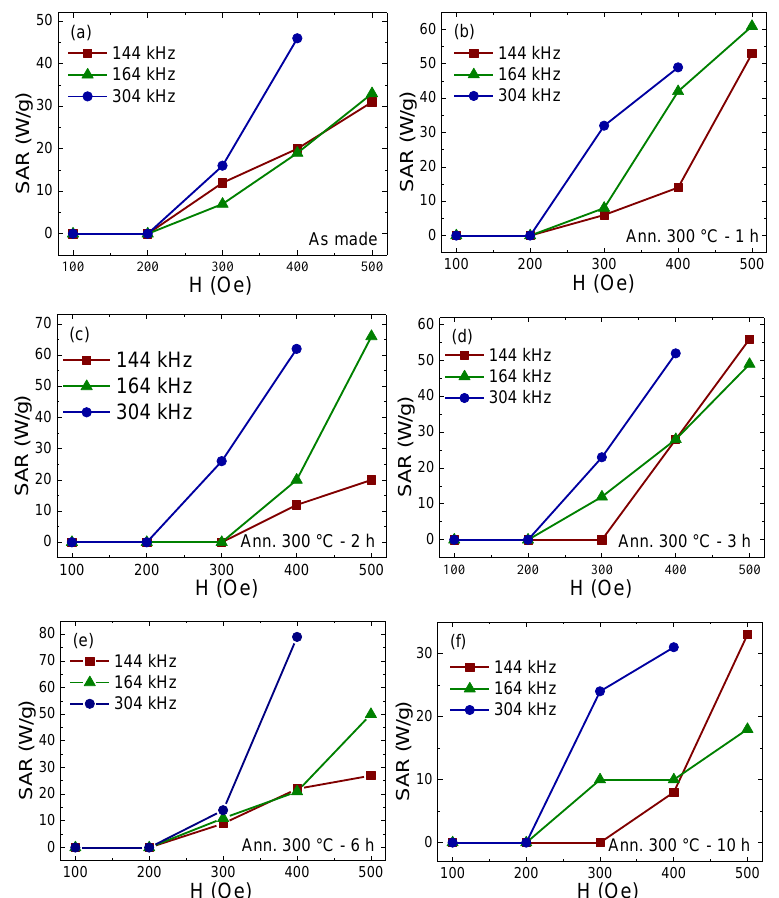
Figure 4. Specific absorption rate (SAR) dependence on applied AC magnetic fields H at different frequencies f for samples ( a ) as-made or annealed at 300 °C for ( b ) 1, ( c ) 2, ( d ) 3, ( e ) 6, and ( f ) 10 h (the points are connected as guidance for the eye).